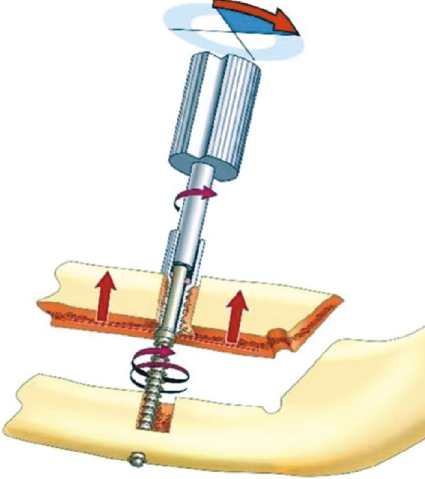
Figure 2: Schematic drawing and split image of the Endo- Distraction Implant Krenkel® and its biomechanical